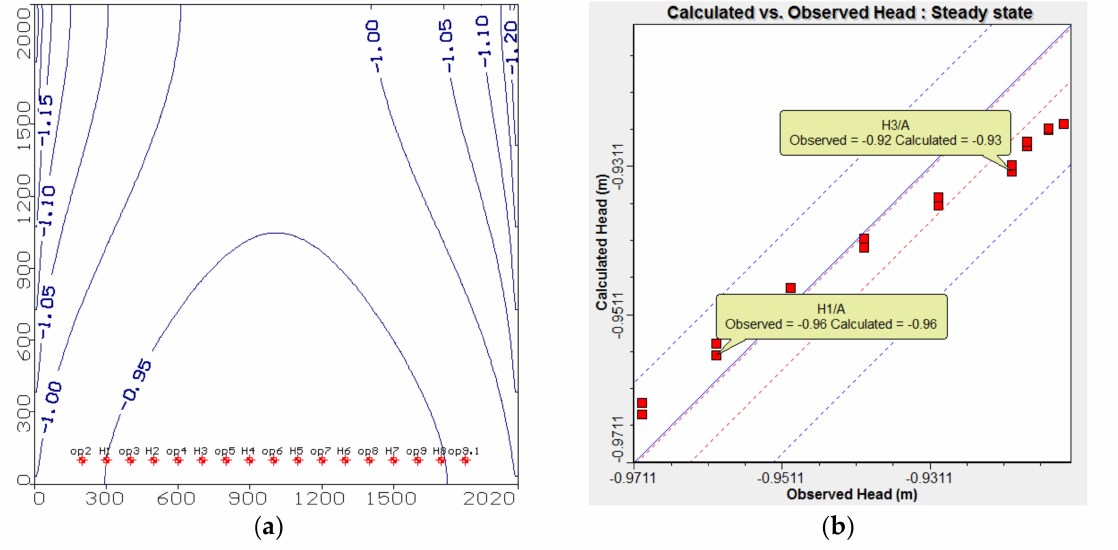
Figure 3. Head contour and model